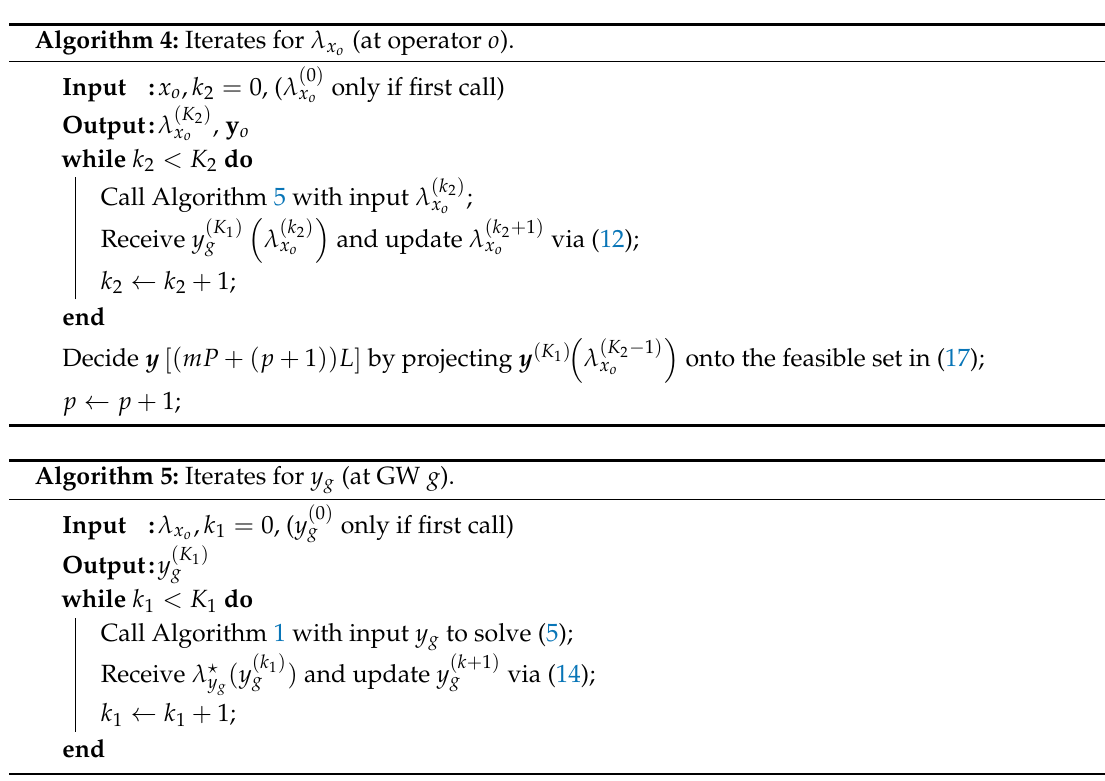
Algorithm 4: Iterates for λ x